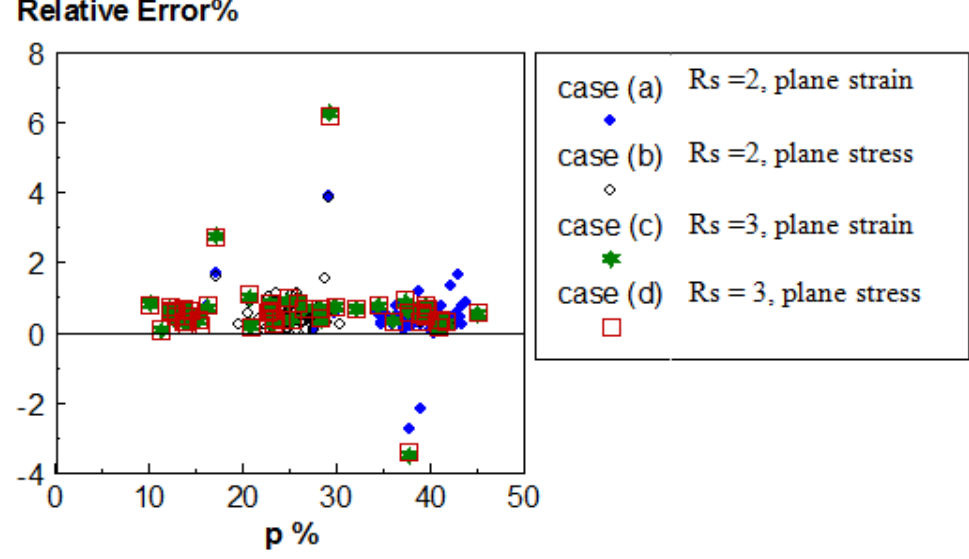
Fig. 5. Accuracy analysis with mesh